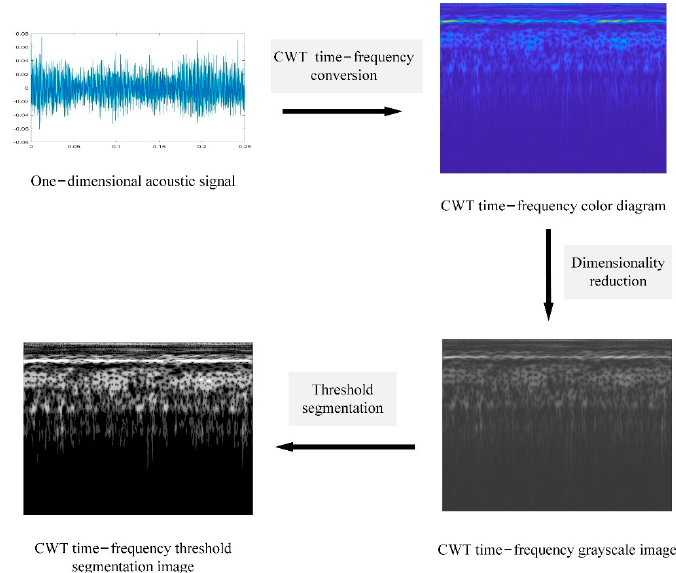
Figure 14. Processing of image samples.